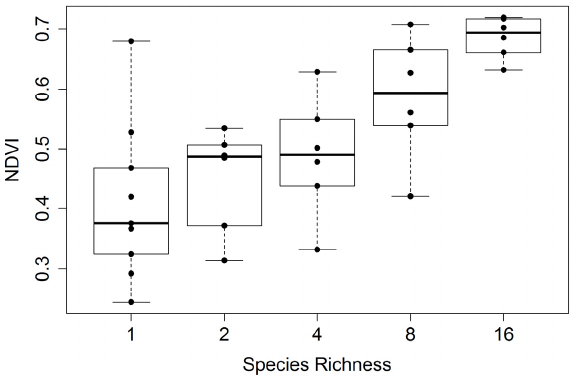
Figure 7. Mid-season whole-plot NDVI versus species richness (collected over several dates spanning 23 July to 3 August 2014). For this figure, 49 (7 m × 7 m) of the 81 measurements in the center of each plot were used to calculate the average reflectance and NDVI, yielding a more representative sampling than shown in Figure 6. Species richness represents the planted number of species per plot. Each richness treatment had a sample size of 6, except monoculture plots, which had a sample size of 9. In this figure, box plots were overlaid on actual data points (dots) that represent the average values for each plot. The regression statistics are provided in Table 2. Table 2. Species richness–NDVI relationships for various dates in 2014 compared to the whole plot results obtained at mid-summer (23 July–2 August 2014).